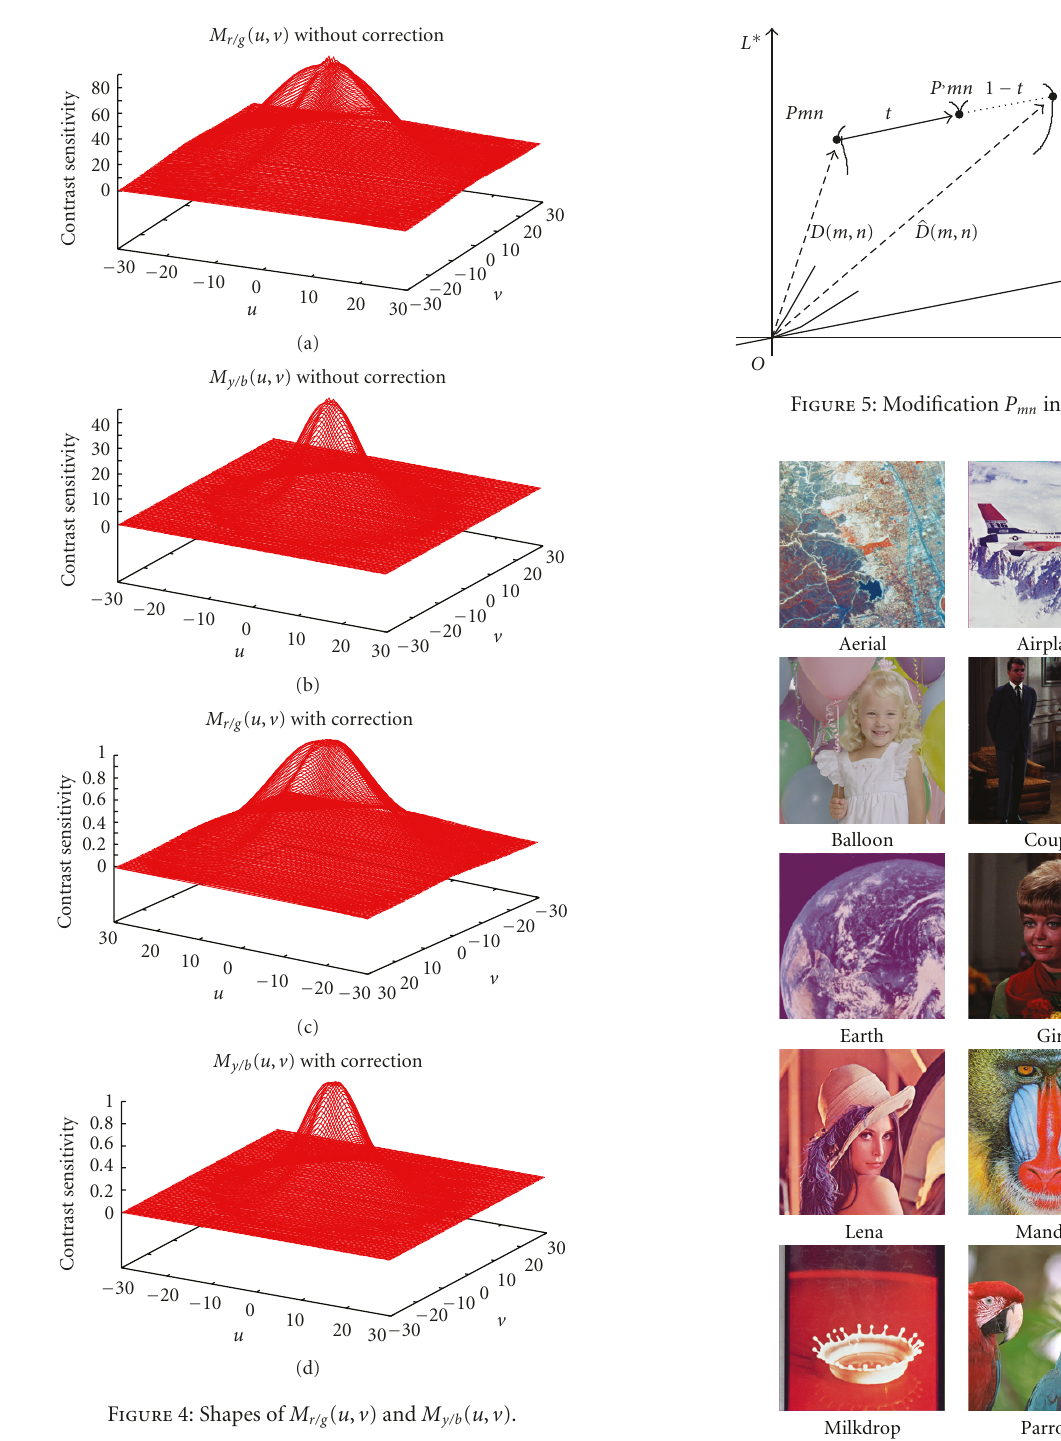
the origin O and the point (cid:25) P mn . D ( m , n ) and (cid:25) D ( m , n ) are